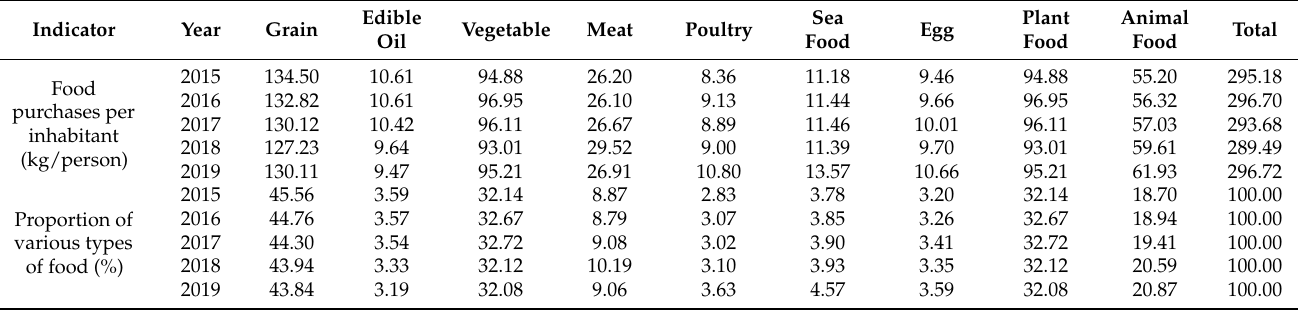
Table 3. Changes in the structure of food consumption of Chinese residents in